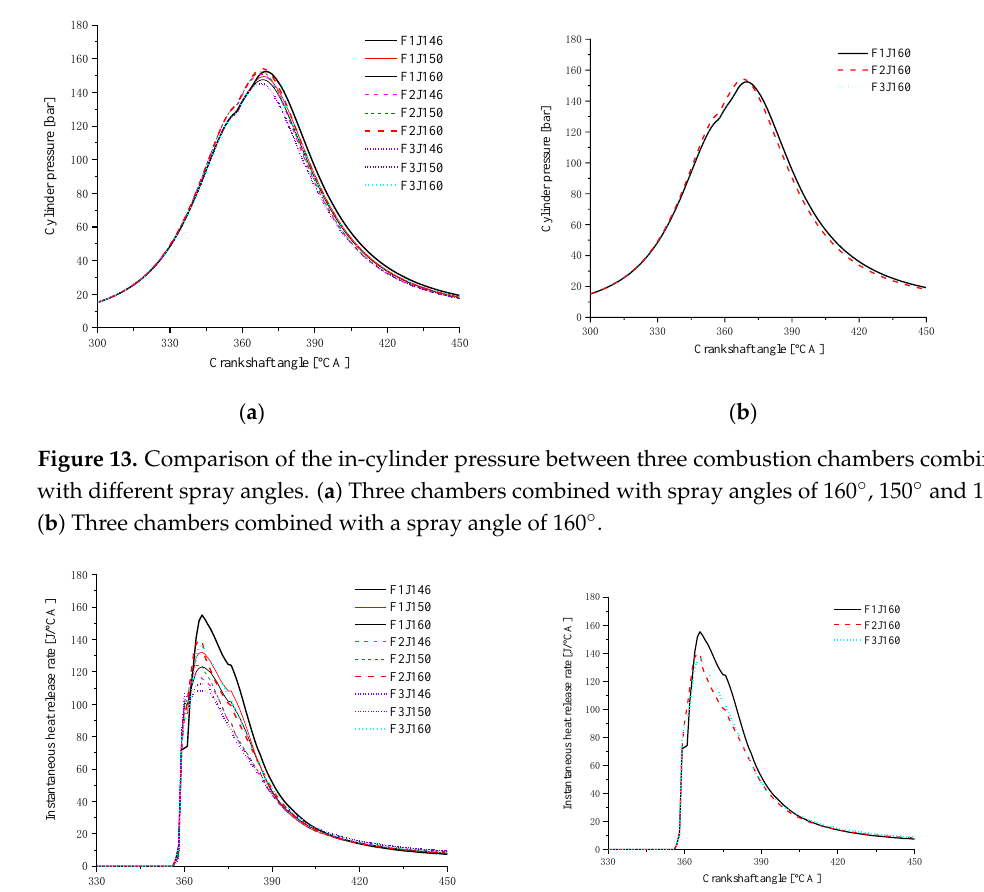
Figure 14. The instantaneous heat release of the three combustion chambers combined with three spray angles. ( a ) Three chambers combined with spray angles of 160°, 150° and 145°; ( b ) Three chambers combined with a spray angle of 160°.